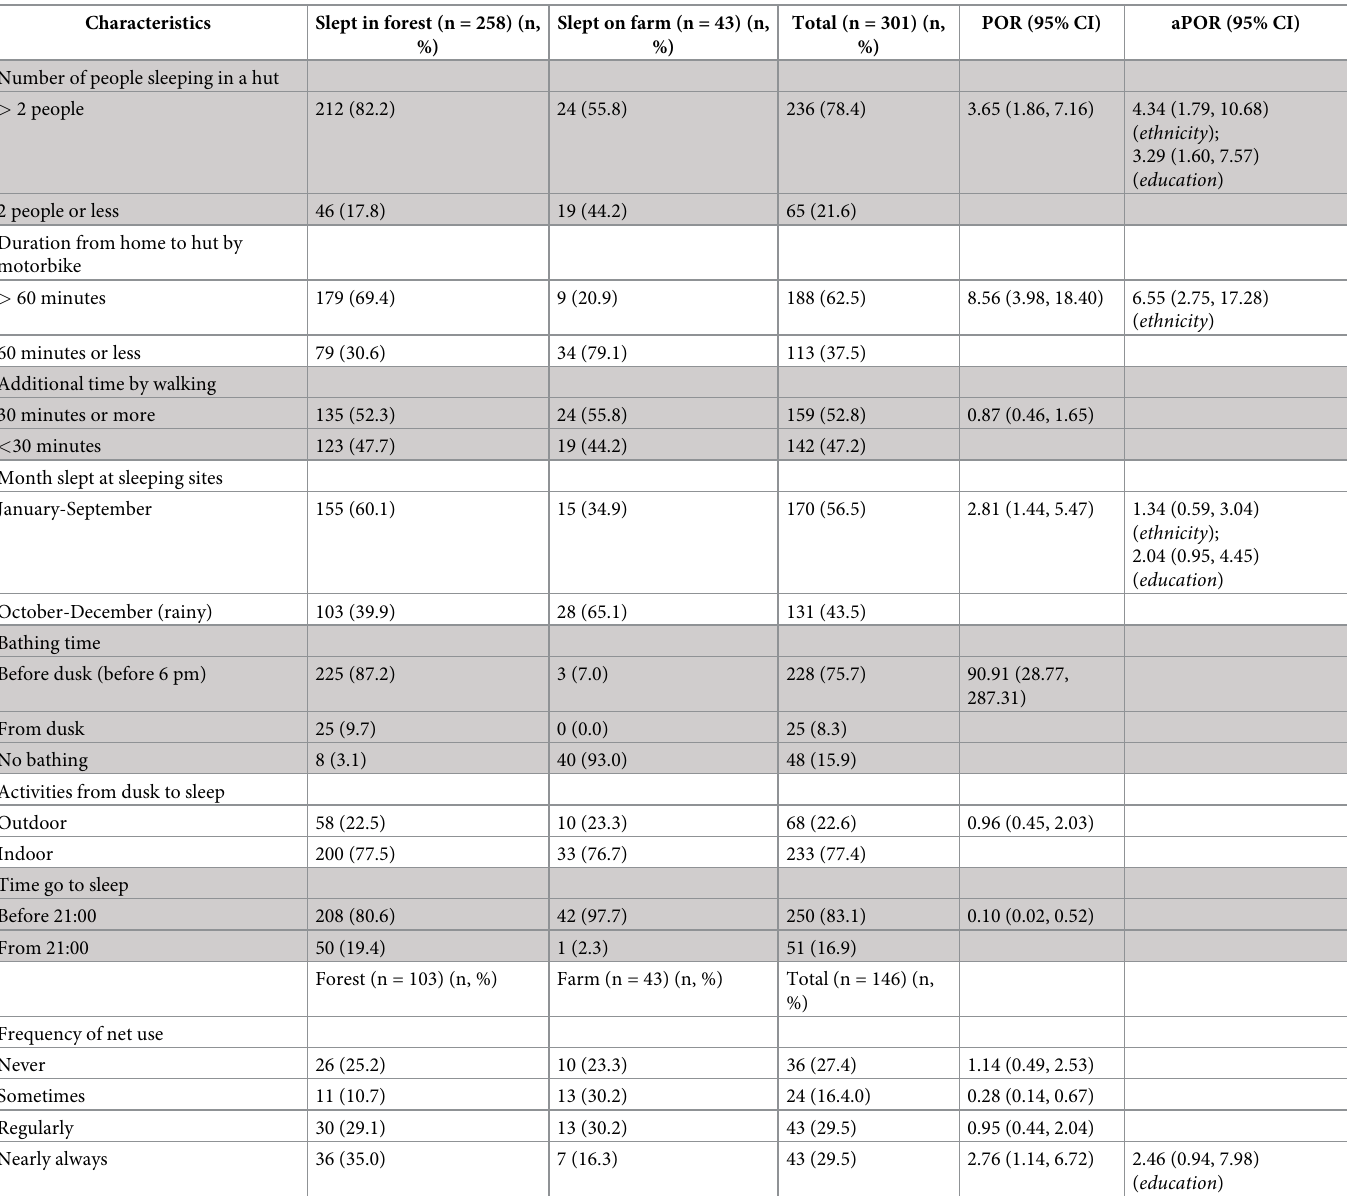
Table 4. Risk factors of respondents who slept in the forest versus on a farm.